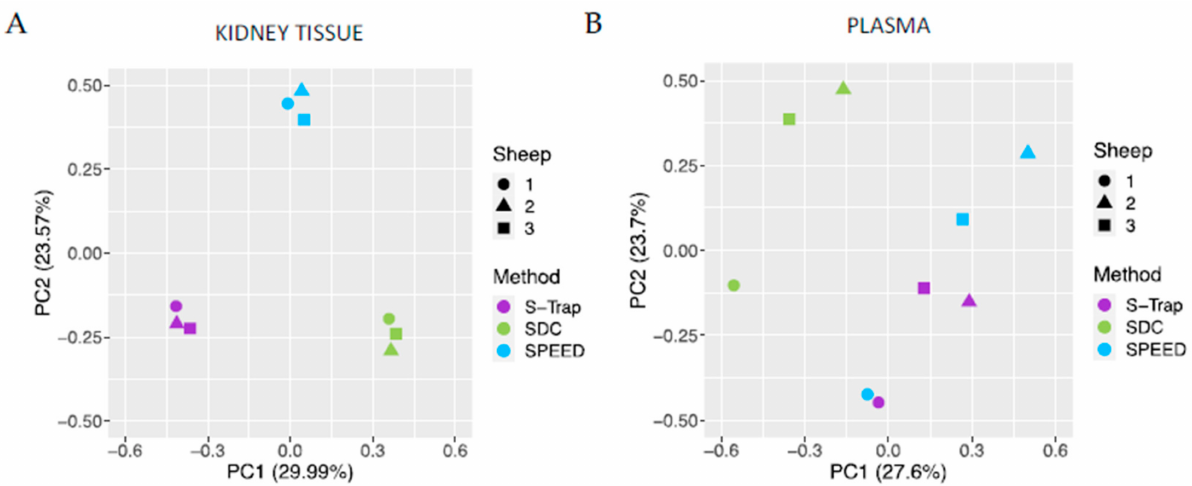
Figure 3. Principal component analysis of SWATH protein intensity data in ( A ) kidney tissue and ( B ) plasma. The color of data points indicates the sample preparation method used, and the shape of data points indicates the identity of the